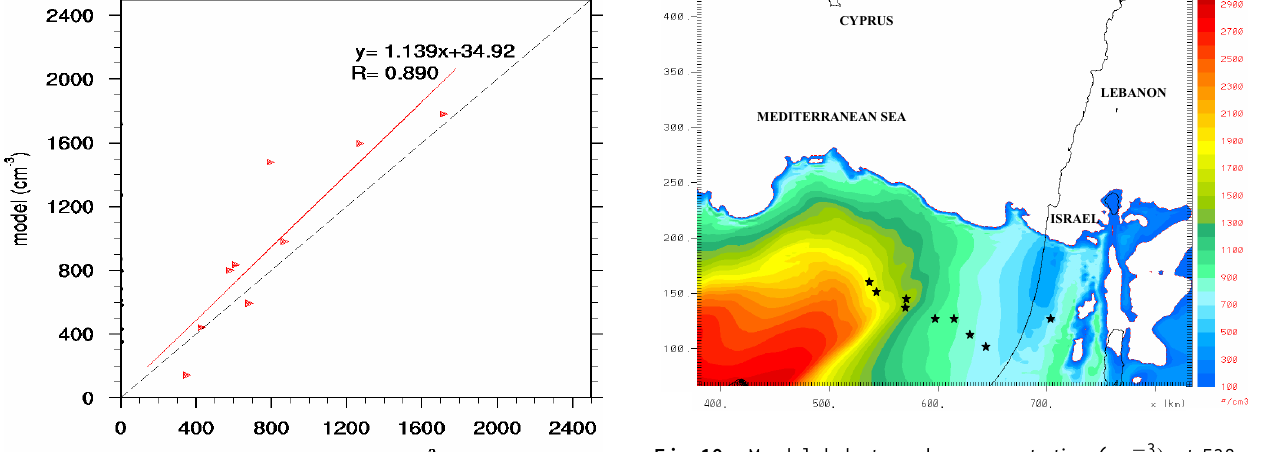
Fig. 10. Modeled dust number concentration (cm − 3 ) at 538m height on 28 January 2003, 09:20UTC. Dots indicate the locations of the aircraft